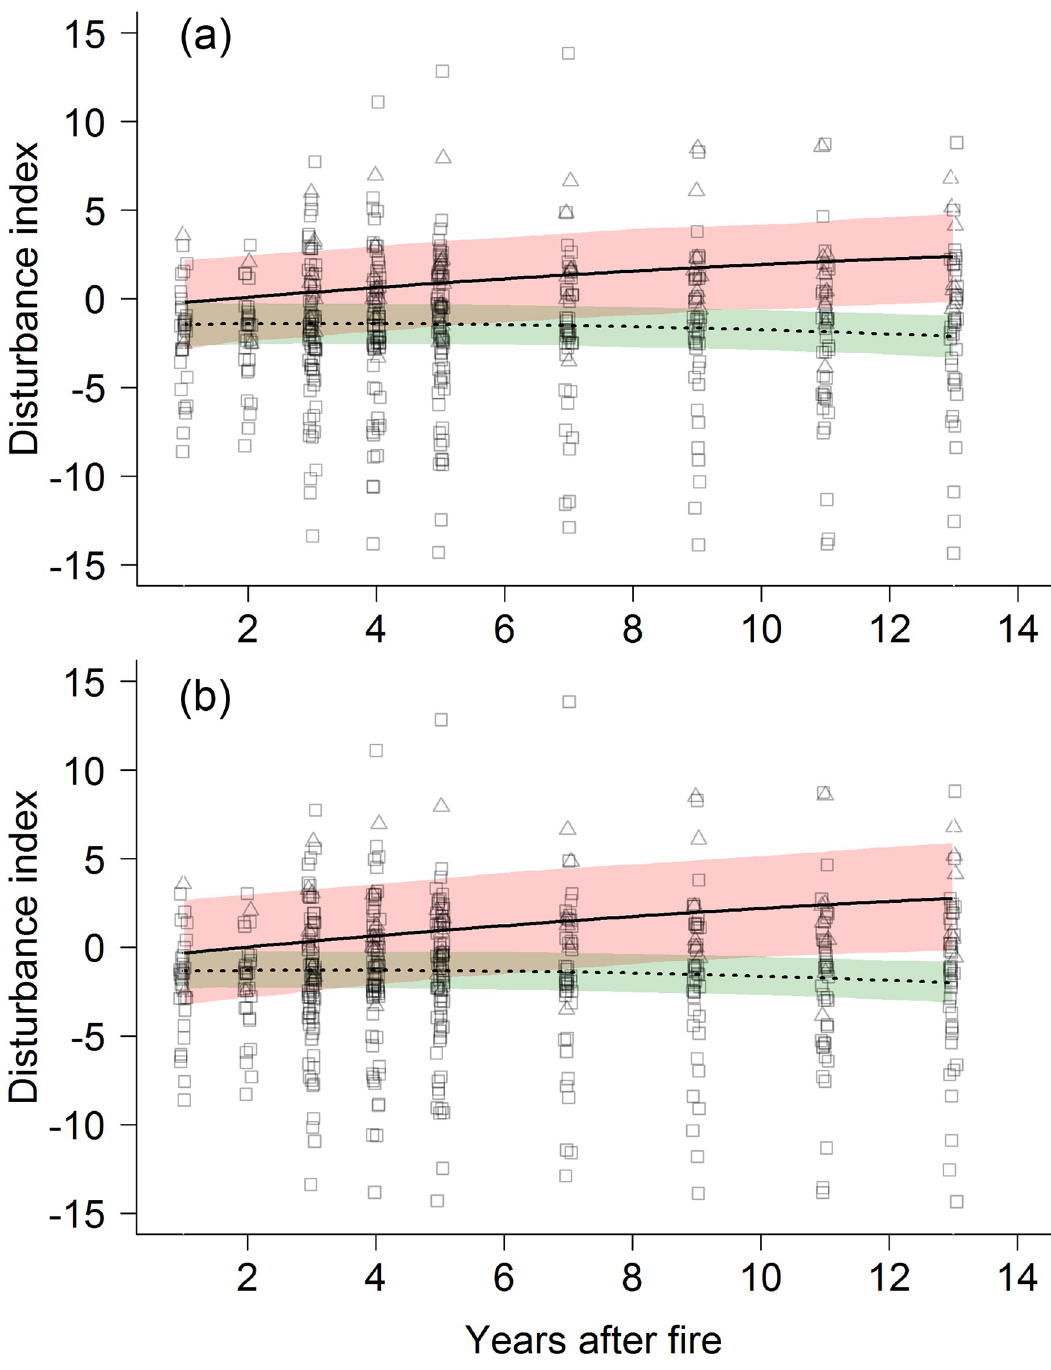
Fig 3. Disturbance index values in relation to years after fire. Shown are regression lines and 95% confidence intervals, for (a) Swiss red-listed bird species, where red = higher red-listed species, green = least concern species, and (b) Swiss priority bird species, where red = Swiss priority species, green = non-priority